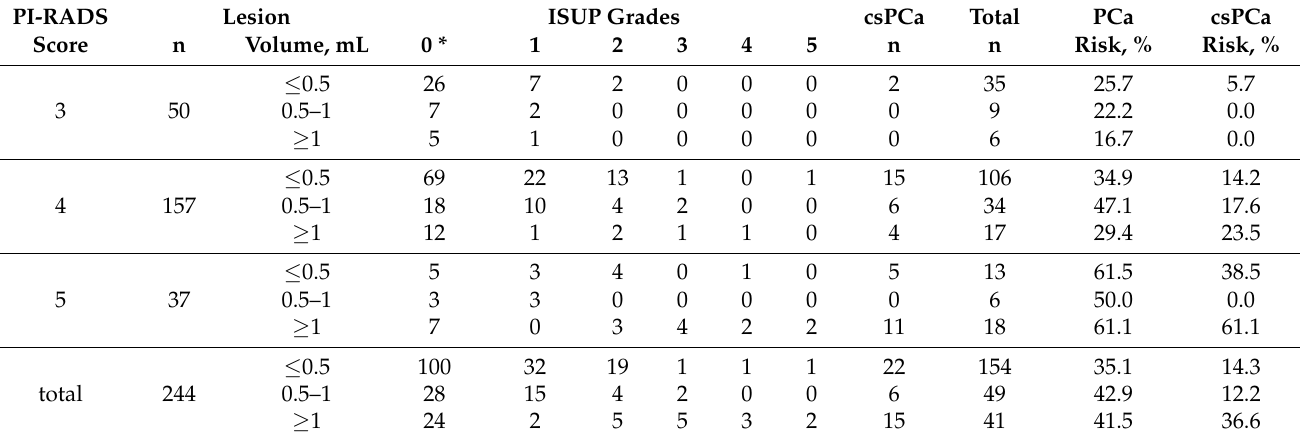
Table 4. Relationship between PI-RADS v2 scores of 3–5, lesion volume, ISUP grades and risk calculation for prostate cancer (PCa) in general and clinically significant prostate cancer